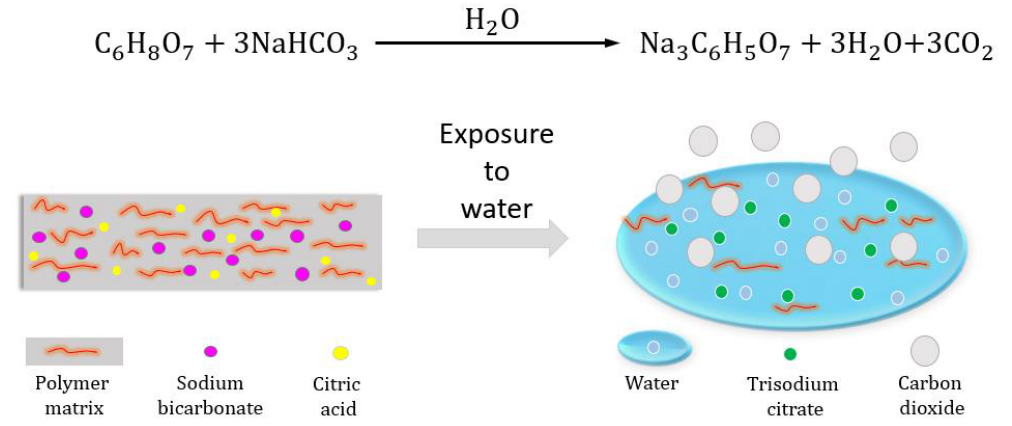
Figure 1. A structural model of active transiency by means of gas-forming reactions.